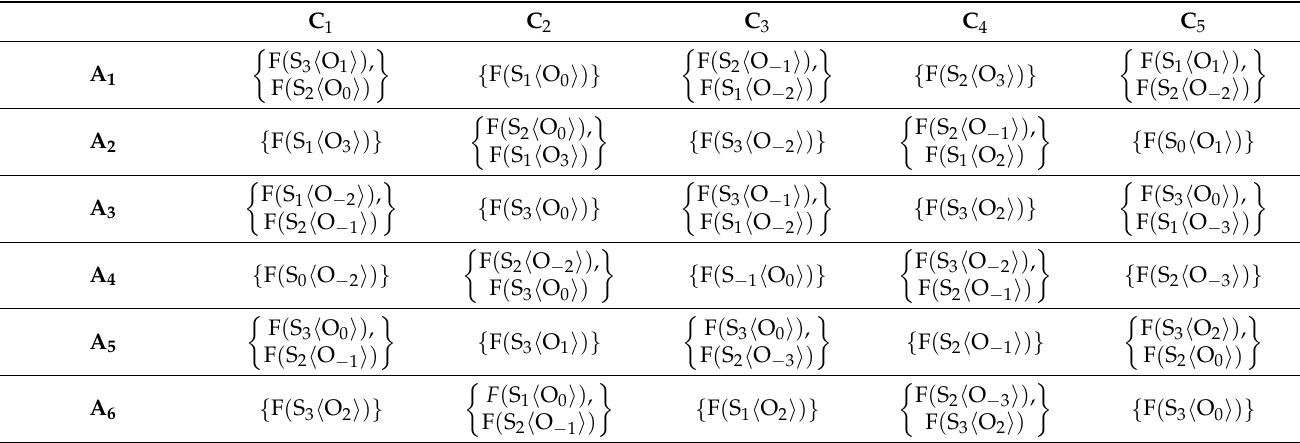
Table 4. The DHHLT information system that corresponds to the S-boxes in image